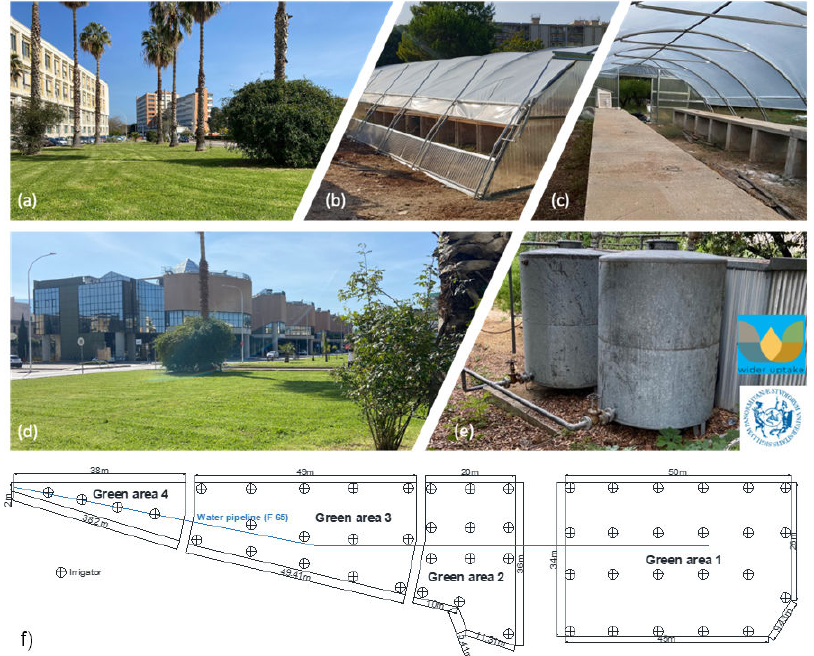
Figure 8. Engineering department green areas and facilities at Palermo University campus: ( a , d , f ) green areas, ( b , c ) greenhouse and ( e ) storage tank for treated